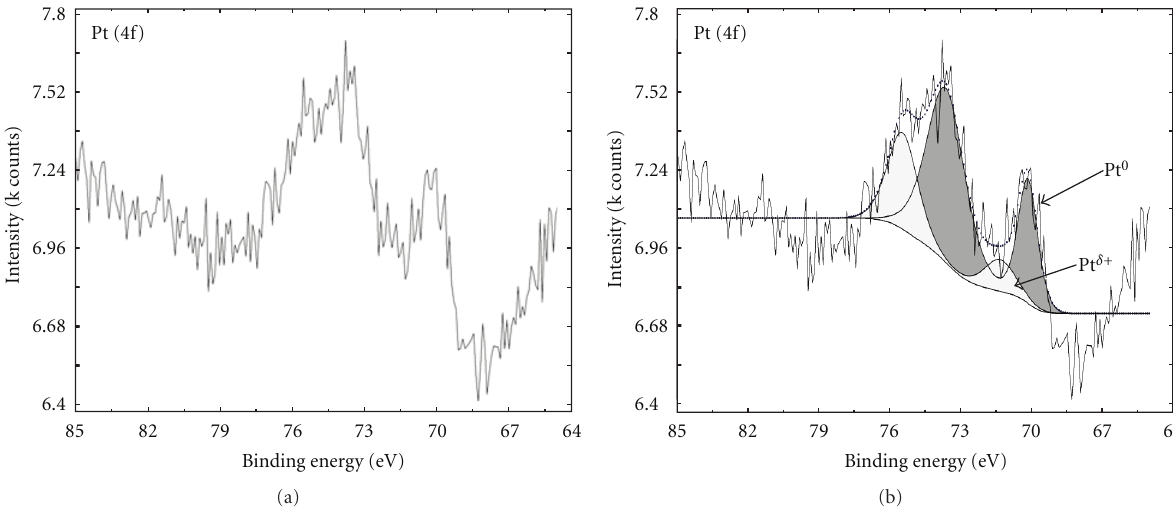
Figure 8: XPS Pt 4f core level for Pt/TiO 2